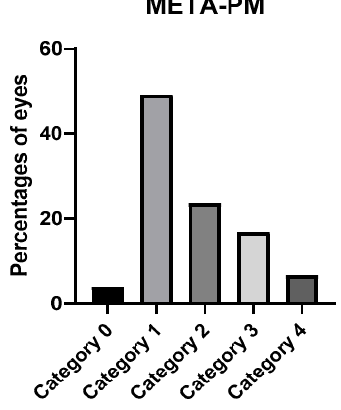
Figure 1. Types of detected staphylomas.